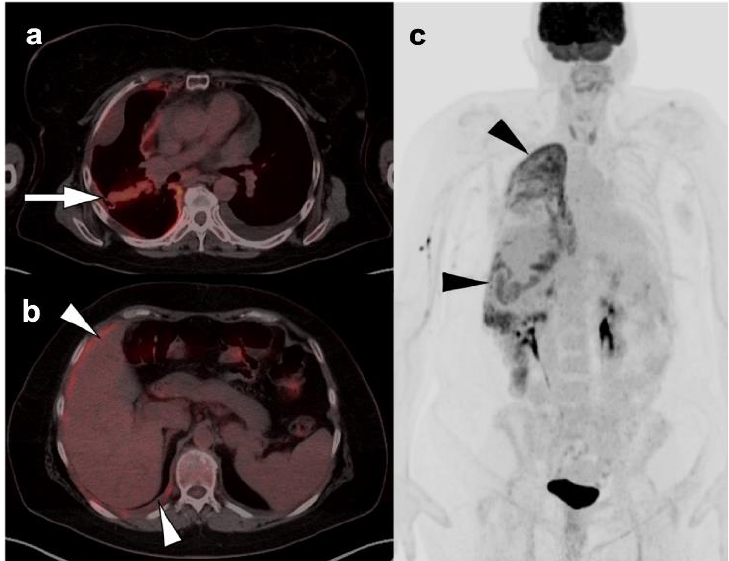
Figure 13. Malignant pleural mesothelioma. ( a ) Axial FDG PET-CT image shows a hypermetabolic rind of soft tissue within the pleura surrounding the right lung and tracking into the major fissure ( white arrow ); ( b ) Axial FDG PET-CT image shows a hypermetabolic tumor in the right deep costophrenic sulcus, which defines the lower margin of the pleural space ( white arrowheads ); ( c ) MIP image of the same FDG PET scan shows the distribution of hypermetabolic tumor in the pleural space ( black arrows ).